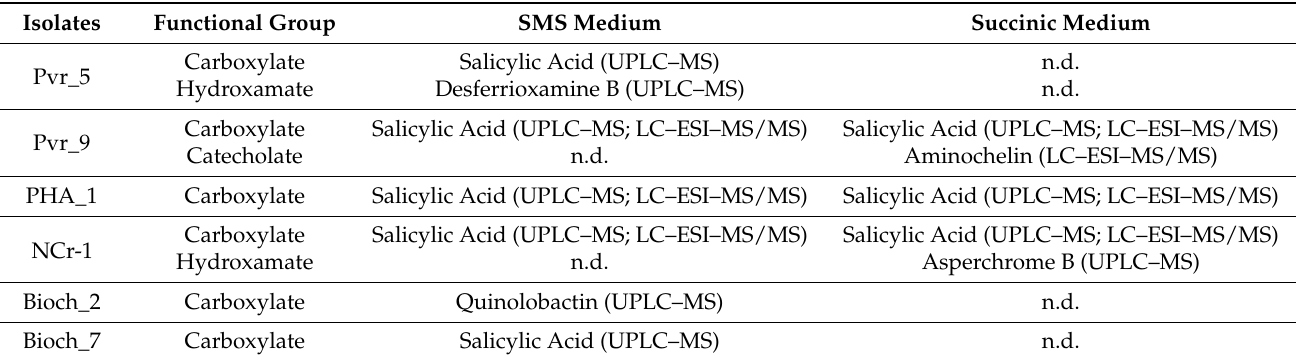
Table 2. Identified molecules produced by bacteria and their relative functional groups, along with the growth medium and the technique used for the analysis (n.d., not